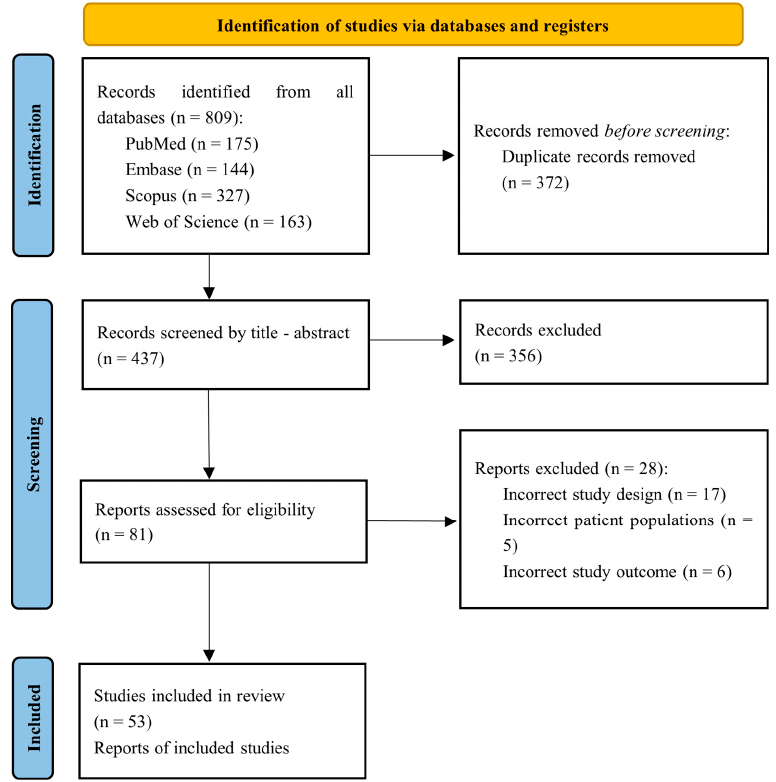
Figure 1. PRISMA flowchart summarizing the process of choosing the studies.